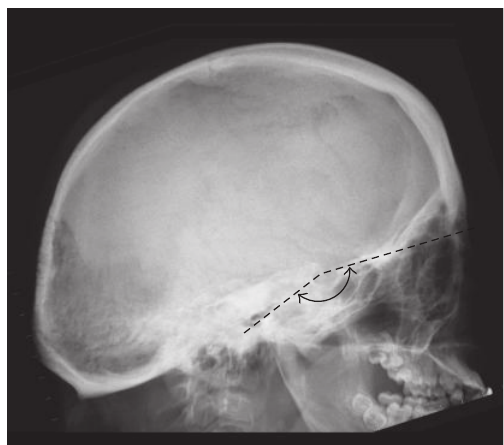
Figure 7: Platybasia: a flat cranial base as a consequence of a flat nasion-sella-basion angle (Welcher basal angle or sphenoid angle > 140 ◦ ).